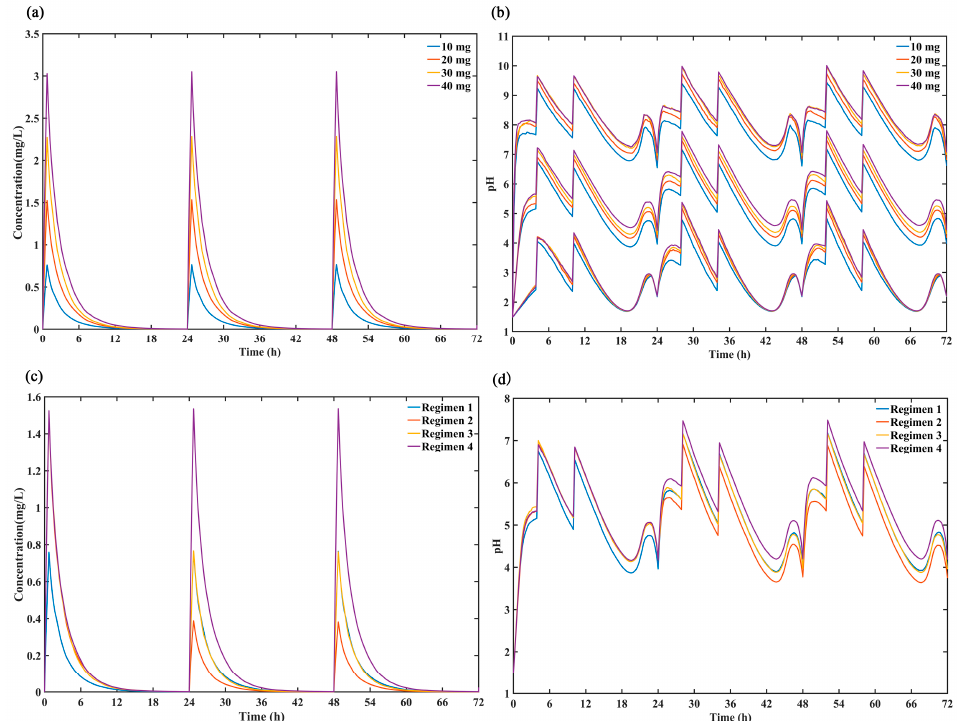
Figure 5. Comparison of the predicted ( a ) 50% percentiles of concentration profiles and ( b ) intragastric pH profiles (5%, 50% and 95% percentiles) after intravenous administration ilaprazole for 3 days of 4 dose group (10 mg, 20 mg, 30 mg and 40 mg). Comparison the simulated 50% percentiles of 24-h ( c ) concentration curves and ( d ) intra-gastric pH curves at 4 dose regimens (Regimen 1: ilaprazole 10 mg once daily for 3 days; Regimen 2: ilaprazole 20 mg followed by 5 mg once daily for 2 days; Regimen 3: ilaprazole 20 mg followed by 10 mg once daily for 2 days; Regimen 4: ilaprazole 20 mg once daily for 3 days).